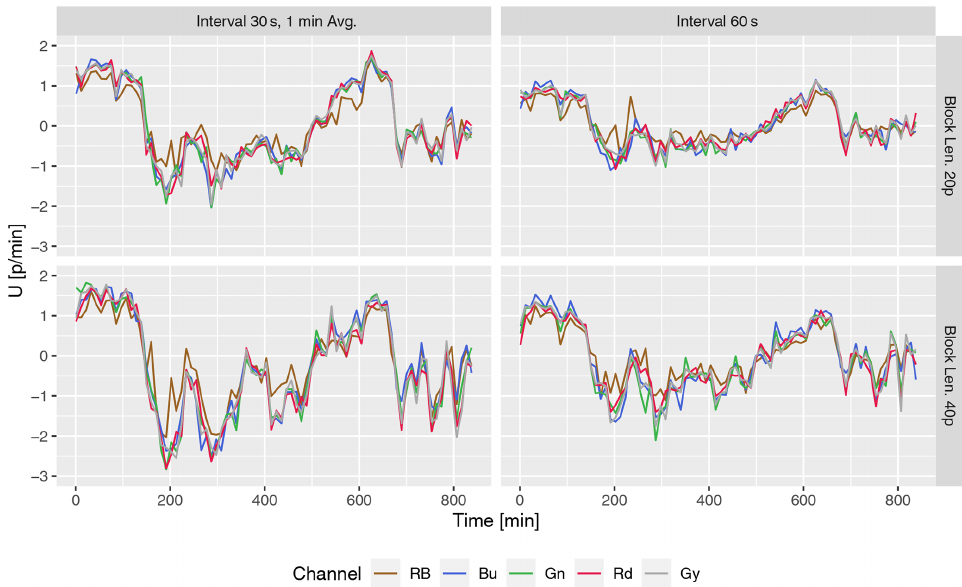
Figure 5. Smoothed time series of U component of domain-averaged CMV (pixel per min − 1 ) on 26 July 2016 06:36 to 20:35CDT (11:36– 01:35 next day in UTC) over Lamont, OK. Variations with block size (20 and 40 pixels) and frame intervals (30 and 60s) are shown for five channels.